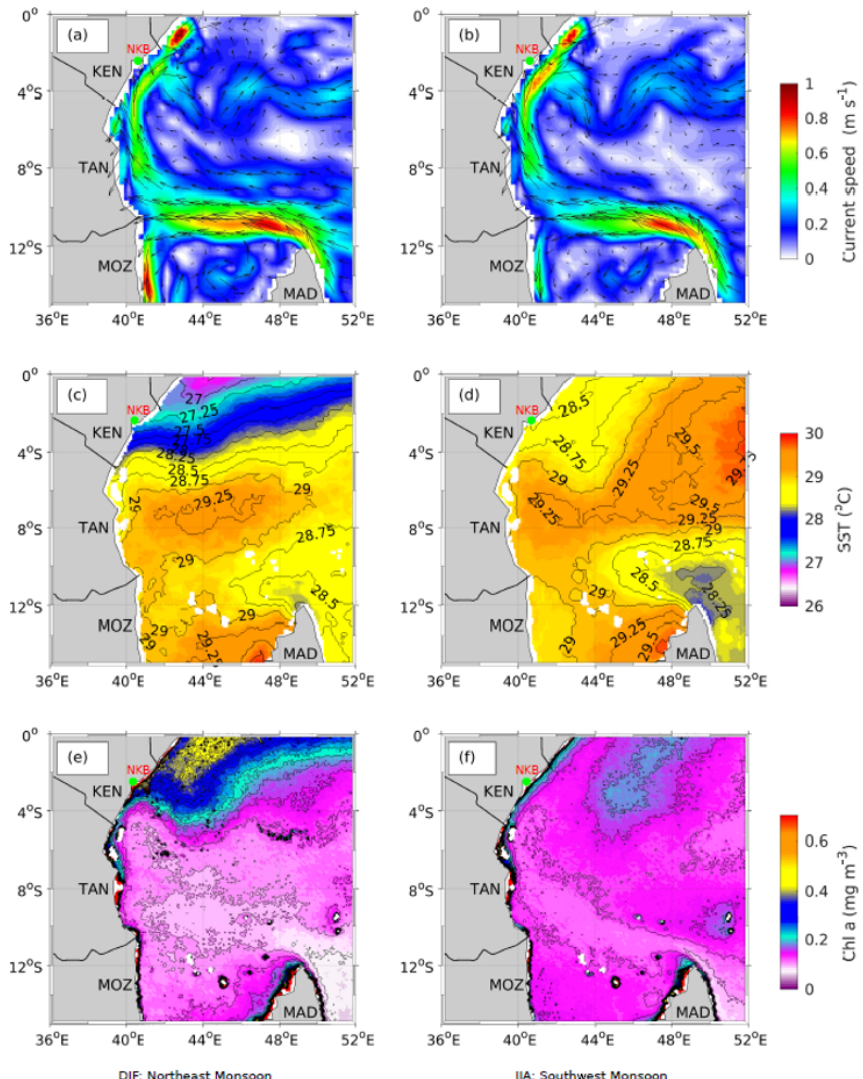
Figure 12. Average surface currents (ms − 1 ) during (a) the NEM (DJF) and (b) the SWM (JJA) derived from daily altimetry (Copernicus Marine Environment Monitoring Services, CMEMS) over the period 2001–2010 (25km resolution); average SST ( ◦ C) during (c) the NEM and (d) the SWM derived from NOAA AVHRR Pathfinder Version 5 data over the period 1981–2012 (4km resolution); and surface chloro- phyll a (mgm − 3 ) during (e) the NEM and (f) the SWM derived from global SeaWiFS data over the period September 1997–December 2010 (4km